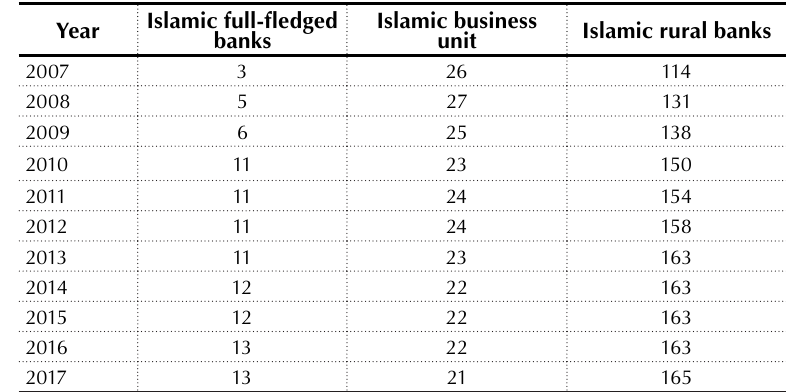
Table 1. The number of Islamic banks in